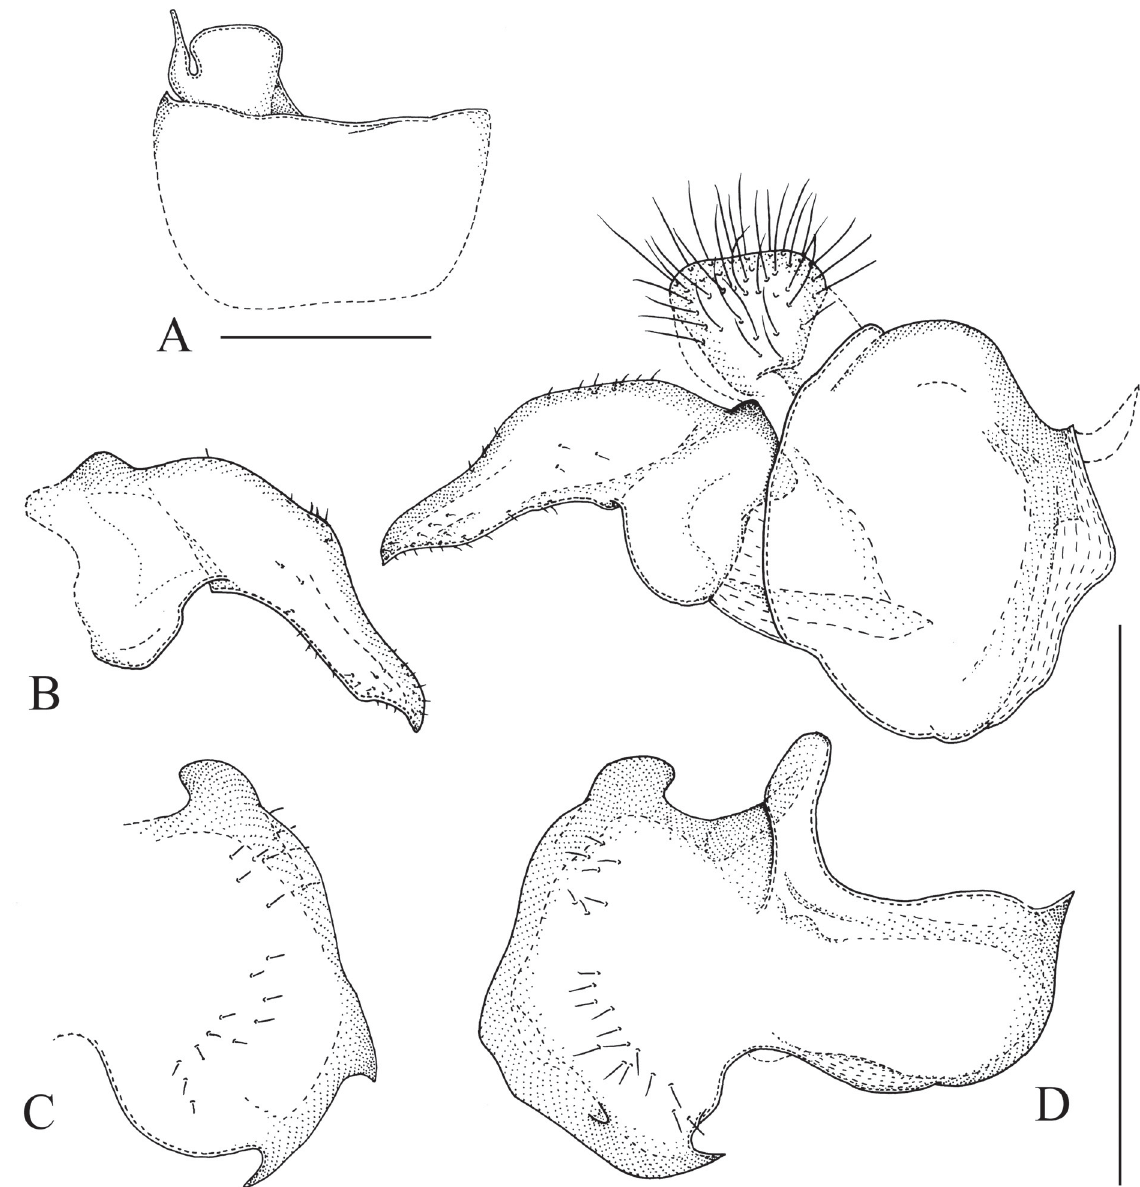
Fig. 49 Sphegina (Asiosphegina) inventum s p. nov., holotype, ♂ . A . Sternum IV, ventral view. B . Left surstylus, lateral view. C . Left superior lobe, lateral view. D . Genitali a, right side, lateral view. Scale bars = 0.5